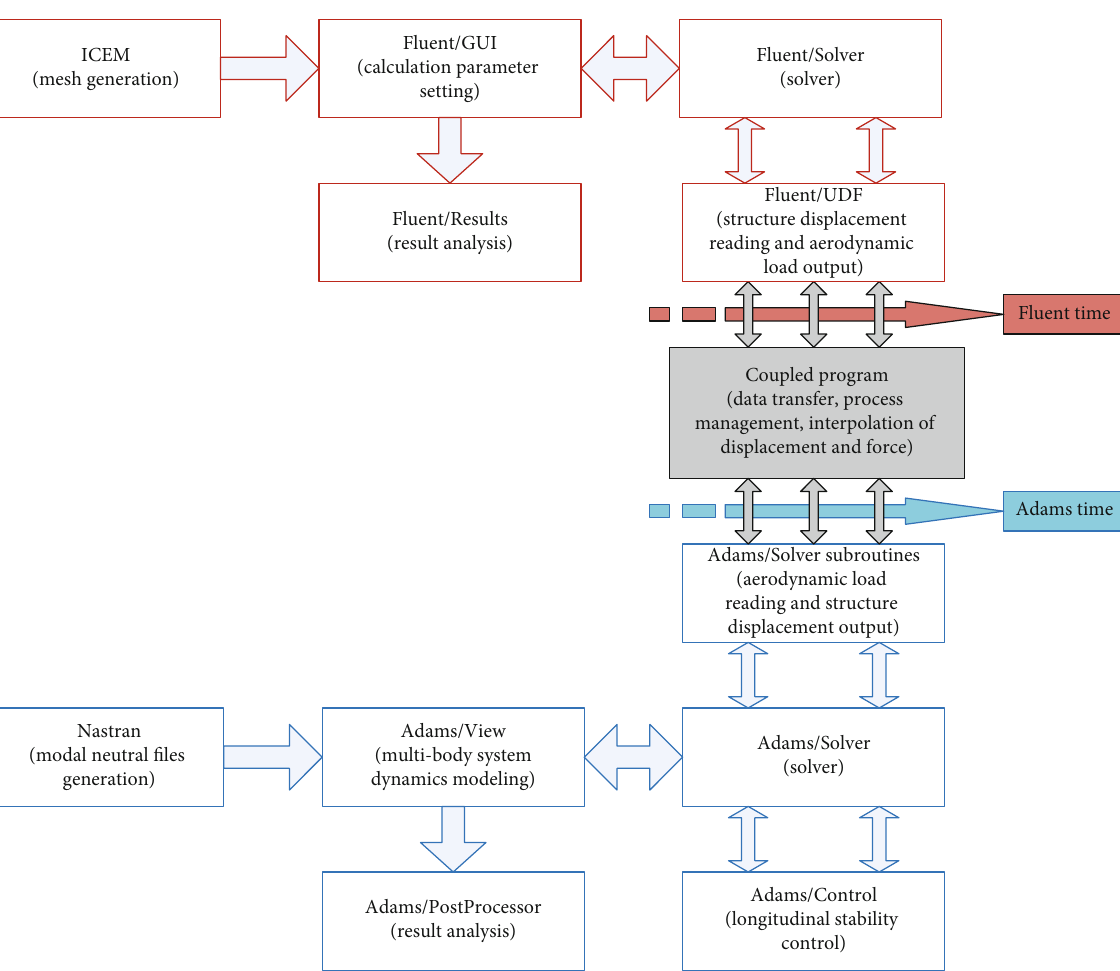
Figure 8: Flight morphing simulation platform.